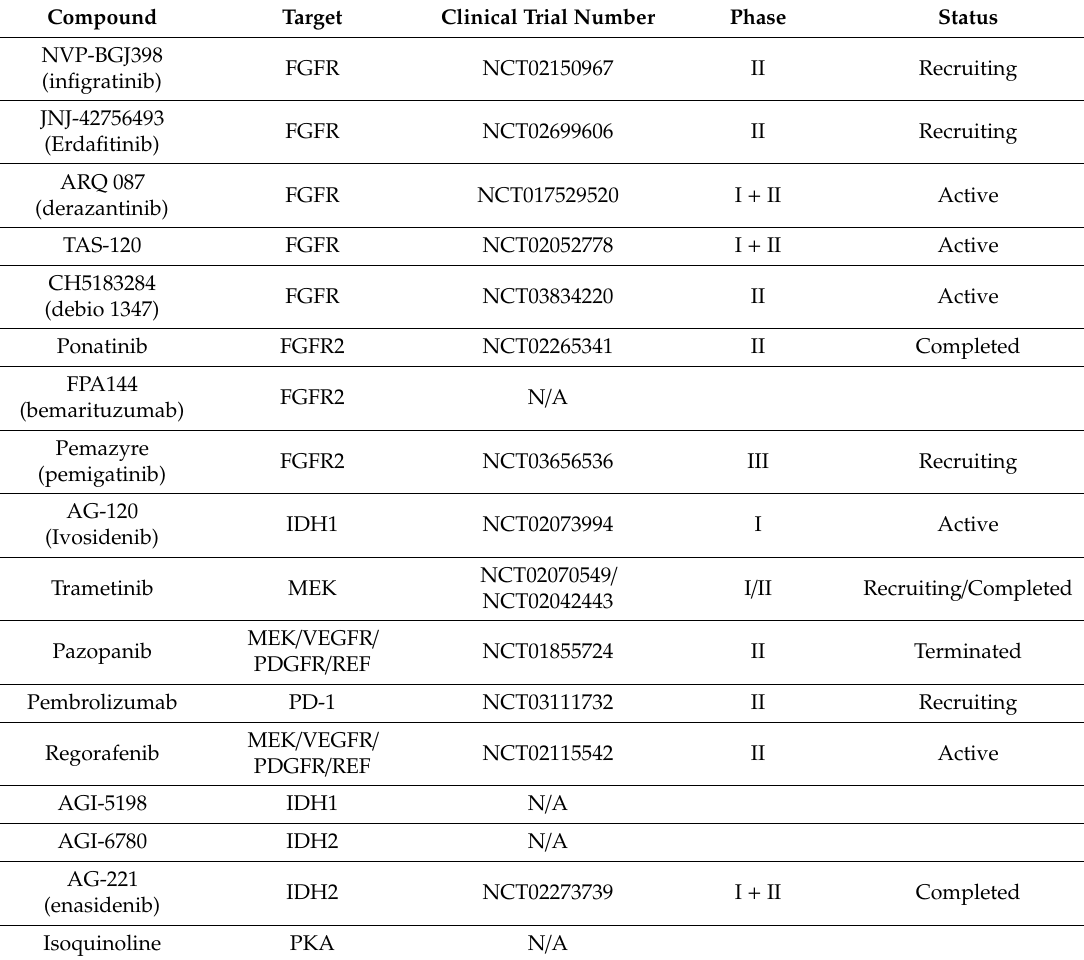
Table 5. Inhibitors and their related clinical trials for